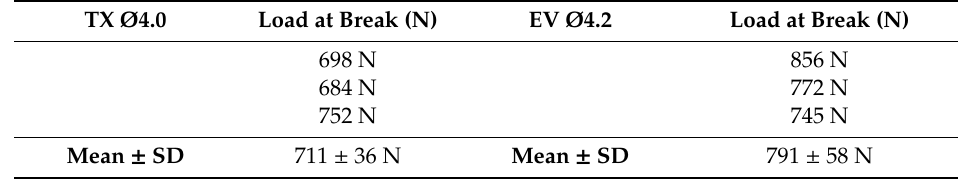
Table 2. Values of the maximum breaking loads in single-load failure tests on three specimens each.